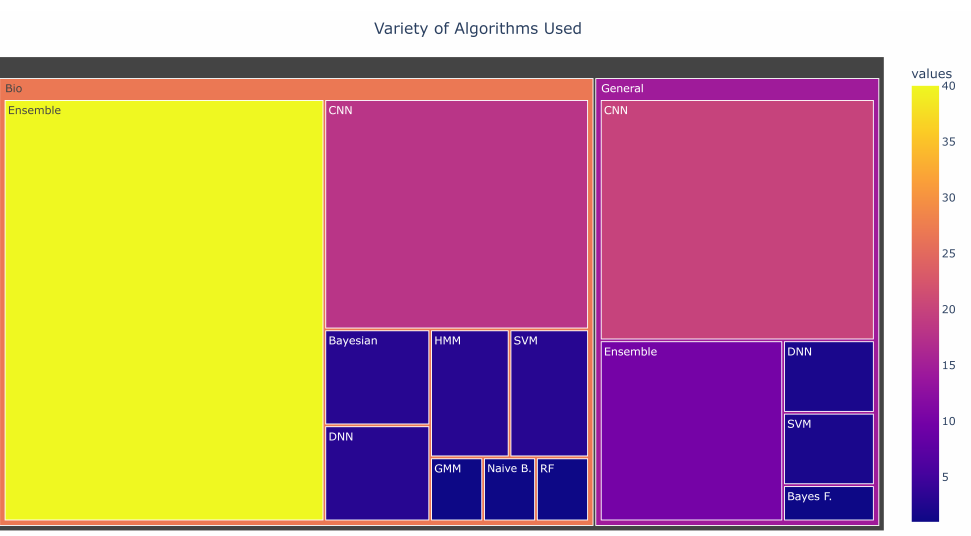
Figure 12. Classification algorithms used for bioacoustics and general acoustics studies.